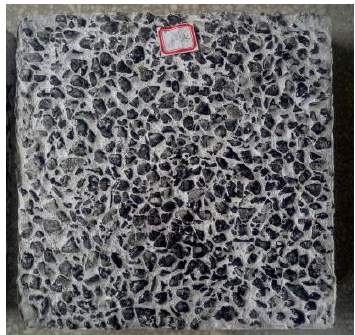
Figure 2. Prepared sample of semi-flexible material.